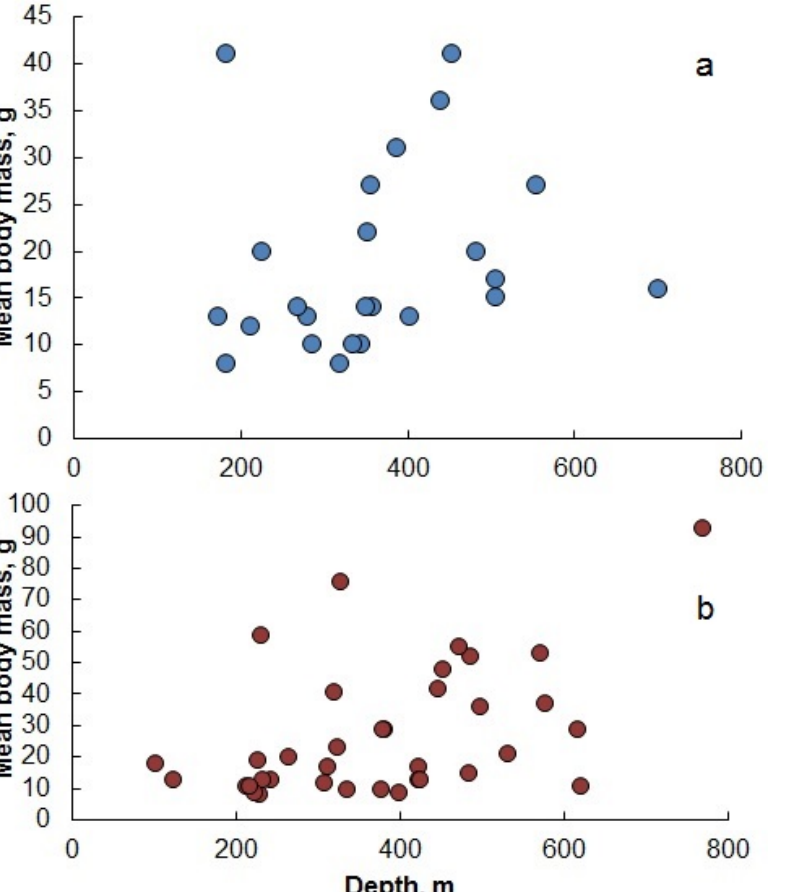
Figure 9. Mean body mass (g) of ice cod Arctogadus glacialis across fjord ( a ) and shelf ( b ) stations in Northeast Greenland in relation to depth of sampling (cf. Table 1 and Figures 1 and 3).